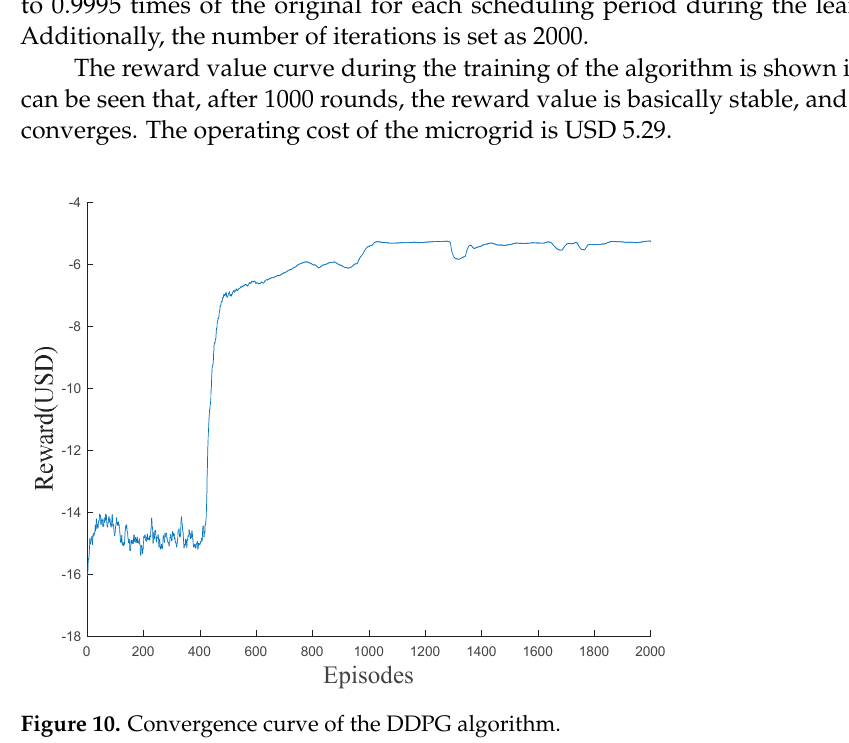
15 of 21 Figure 9. Architecture of the network. ( a ) The strategy network. ( b ) The evaluation network. The decay rate of the DDPG algorithm γ is 0.9. The learning rate of the strategy net- work is 0.0001. The learning rate of the evaluation network is 0.001. A total of 64 samples are selected for each learning process. The size of the experience pool is 10,000. The stand- ard deviation of Gaussian noise is 1. The standard deviation of Gaussian noise is reduced to 0.9995 times of the original for each scheduling period during the learning process. Additionally, the number of iterations is set as 2000. The reward value curve during the training of the algorithm is shown in Figure 10.